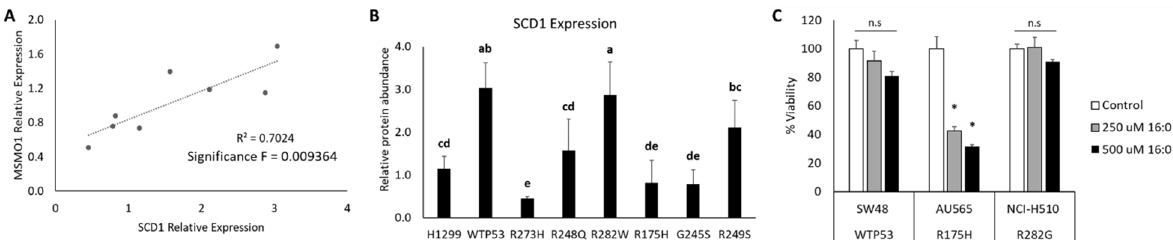
Figure 7. SCD1 protein expression correlates with MSMO1 abundance and improved lipid handling in cells expressing distinct TP53 subtypes. Relative abundance of MSMO1 and SCD1 protein levels in TP53 null H1299 cells (H1299), or H1299 cells expressing tetracycline inducible plasmids containing either wild-type TP53 (WTP53) or one of the designated TP53 mutation types, were measured by quantitative LC MS/MS following 48 h treatment with 10 µM tetracycline. ( A ) MSMO1 and SCD1 protein expression correlation was determined by linear regression analysis. ( B ) Bar graph representing the quantitative differences in SCD1 expression between TP53 mutation types. ( C ) Differences in cell viability in cells expressing endogenous WT TP53 (SW48), an R282G TP53 mutation (NCI-H510), of an R175H mutation (AU565) following treatment with a vehicle control (Control), 250 µM, or 500 µM palmitic acid (16:0) for 24 h. Superscripts (a,b,c) denote statistical difference between TP53 subtypes. Subtypes with the same superscripts are not statistically different. * Denotes statistical difference from respective control, * p < 0.05, n.s. = not signifinct. Error bars indicated SEM.